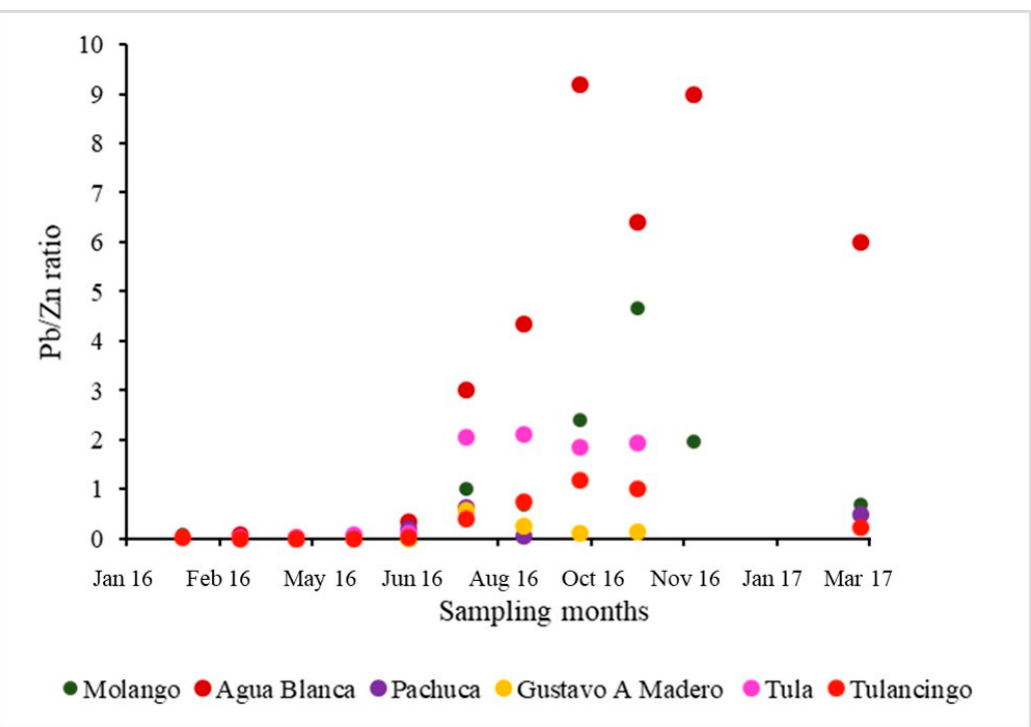
Figure 3. Pb/Zn concentration ratio in the study area during March 2016–2017. Figure 3. Pb / Zn concentration ratio in the study area during March